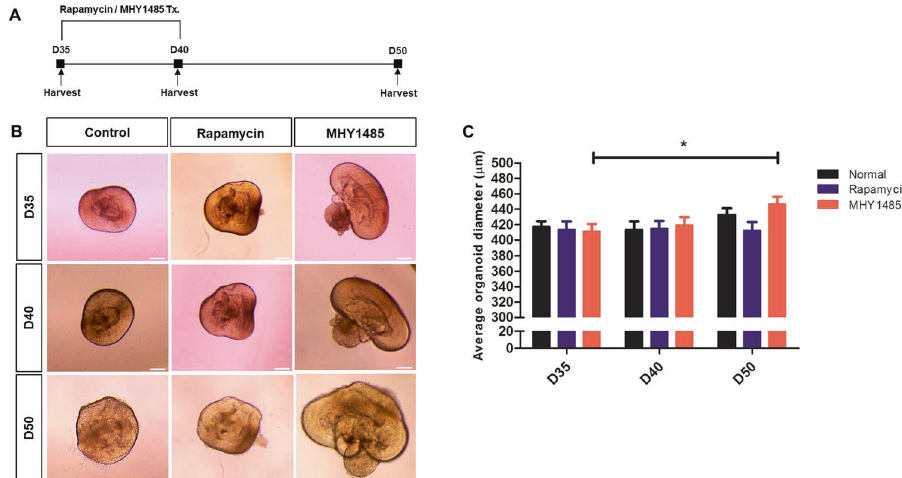
Fig. 3 mTORC1 activity during early differentiation affects the overall size of ROs. A From day 35 to day 40, rapamycin and MHY1485, which are mTORC1 inhibitor and activator, respectively, were administered daily to investigate the role of mTORC1 in RO. B Light microscopic images of control, rapamycin-treated, and MHY1485-treated ROs at indicated time-points of development. C The average diameter of ROs at indicated time points. Data are expressed by mean ± S.E.M. * p < 0.05 by the Kruskal – Wallis test with post hoc analysis. Scale bar, 100 μ